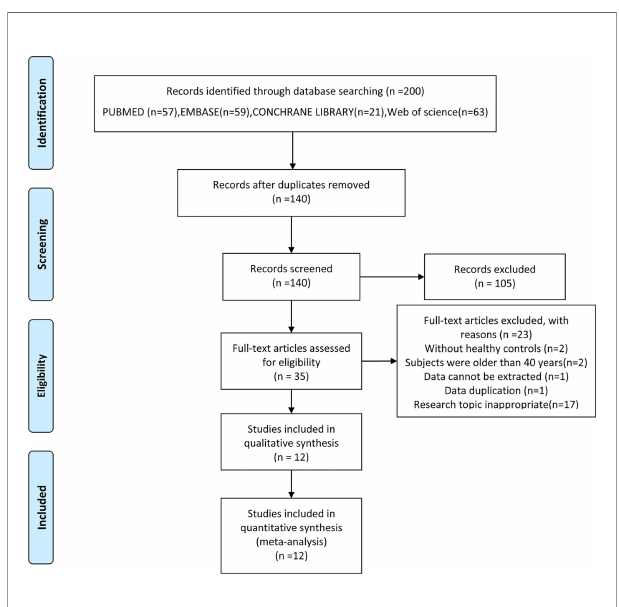
FIGURE 1 | Flow chart of the selection process. From